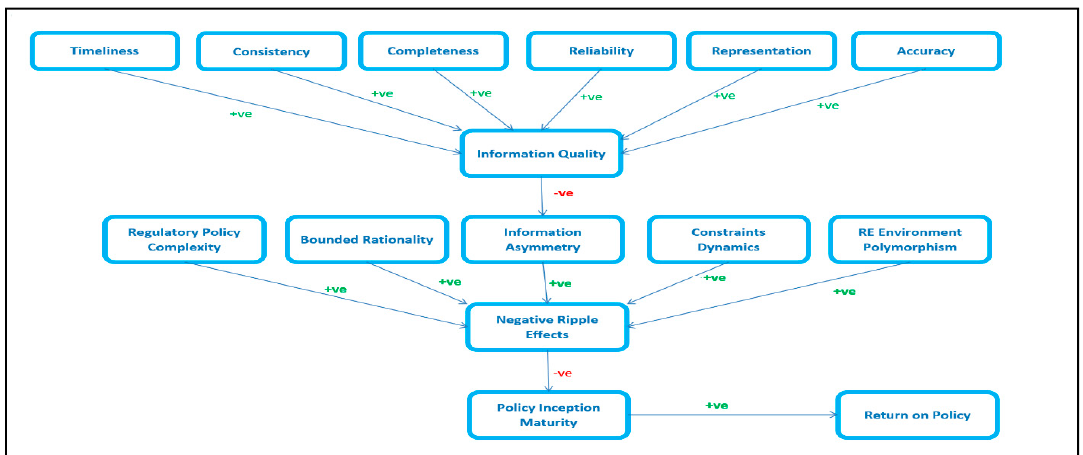
Figure 1. The correlation of information quality dimensions and negative ripple effects factors on policy implementation.